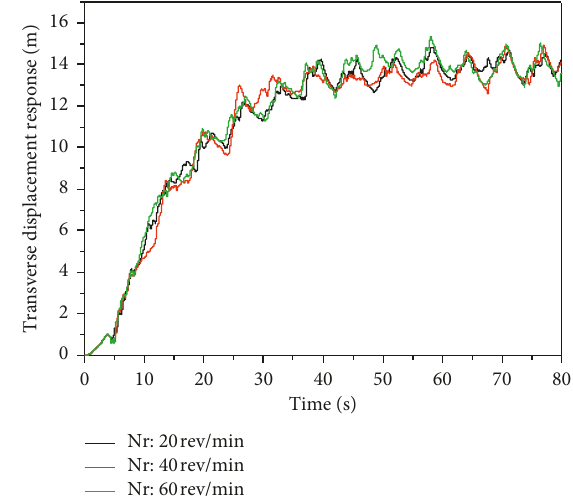
Figure 21: Effect of bit speed on transverse displacement response.